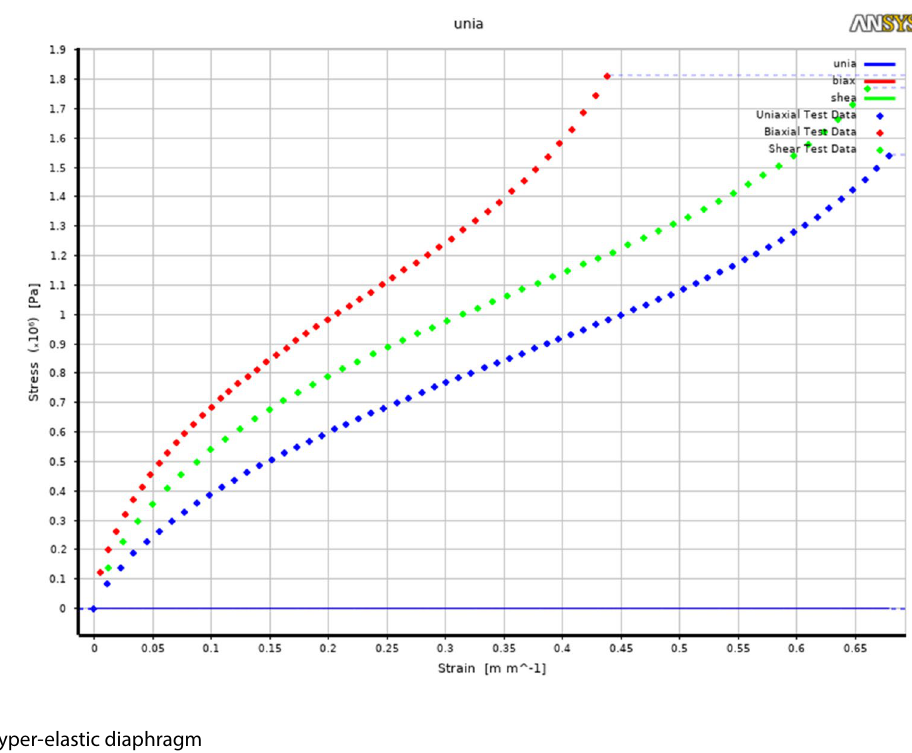
Fig. 7 The software Yeoh 3rd- order automatic curves fitting from the experimental data